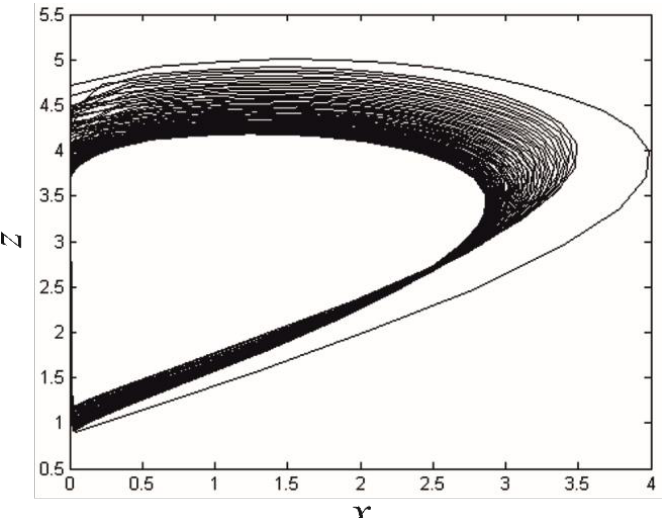
Figure 10. Bidimensional attractor ( x , z ) for high flux in dynamic Györgyi–Field system ( α = 3000/9; β = 6/23; C = 0.001; A = 0.14 mol; M = 0.3 mol; H = 0.26 mol and k f = 6.18 × 10 −4 ).